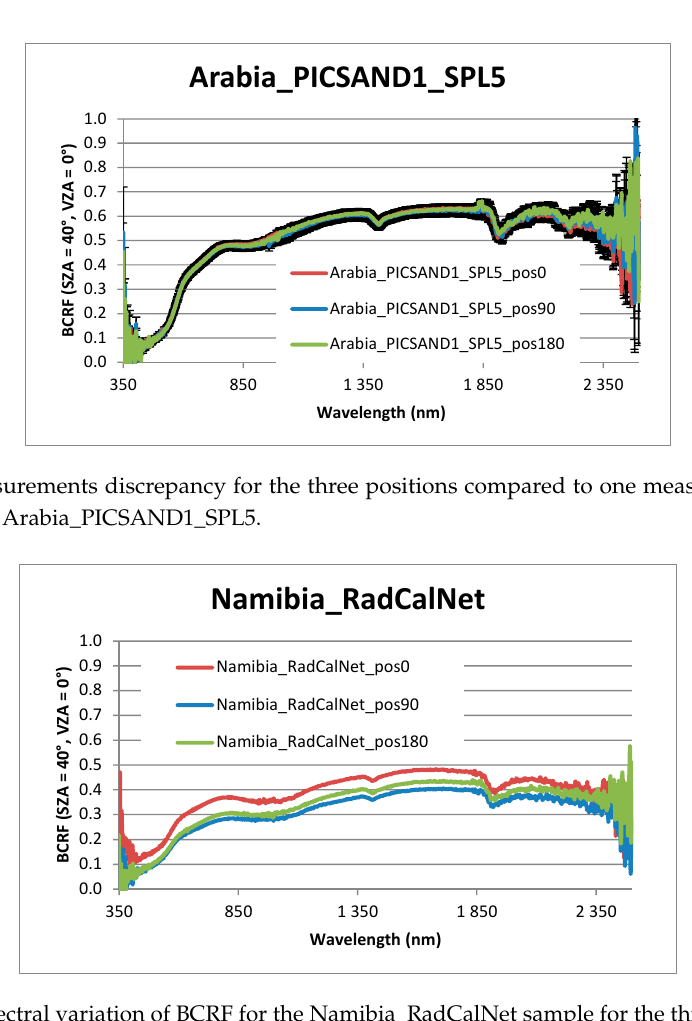
Figure 2. Examples of sand samples: ( a ) Namibia_RadCalNet; ( b ) Arabia_PICSAND1_SPL5.